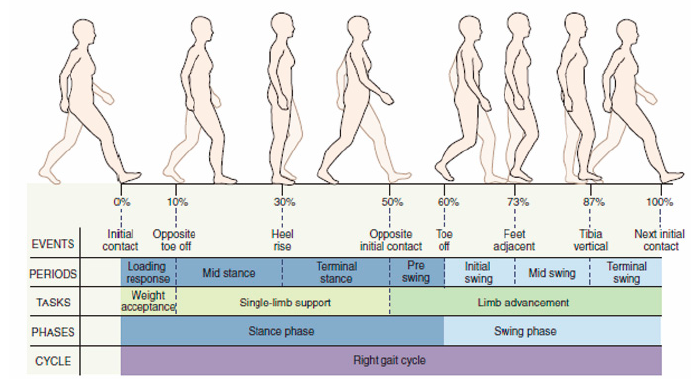
Figure 1 . Gait-cycle phases (reproduced with permission from [19]). Figure 1. Gait-cycle phases (reproduced with permission from [19]). three periods: two “double-support” periods (i.e., periods in which both the feet touch the ground), one at the beginning (initial double support) and the other at the end